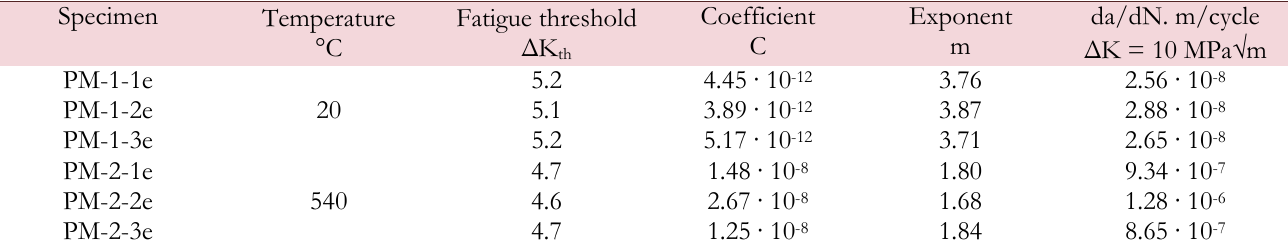
Table 6: Fatigue crack growth parameters for specimens with notches in exploited PM.